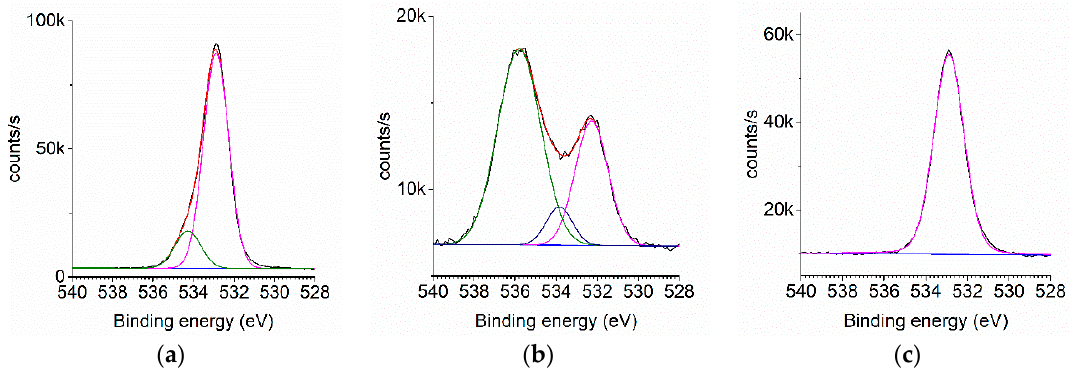
Figure 6. Decomposition of O 1 s peaks for uncapped quartz samples: ( a ) Q7 500 c., unsputtered; ( b ) Q10 1000 c., unsputtered; and ( c ) Q10 1000 c., Ar-sputtered.